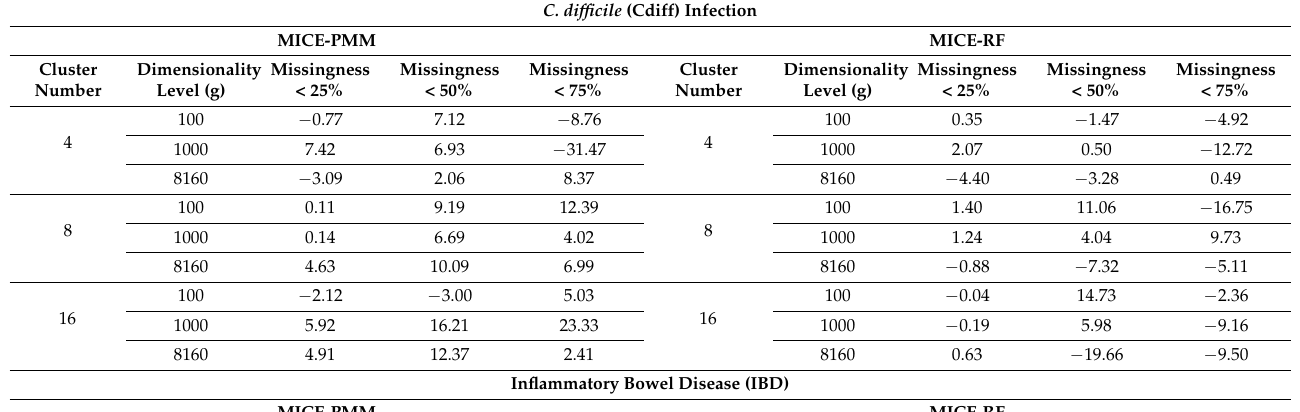
Table 1. The root mean square error (RMSE) difference from imputation is applied with and without the integration of comorbidity information for the three datasets. Negative RMSE correspond to improvements by the hybrid approach. The predictive mean matching (pmm) and Random Forest (rf) model in Multivariate Imputation by Chained Equations (MICE) were used in this study. The reader is referred to Tables A3–A5 for a more comprehensive results, with p -values reported from multiple